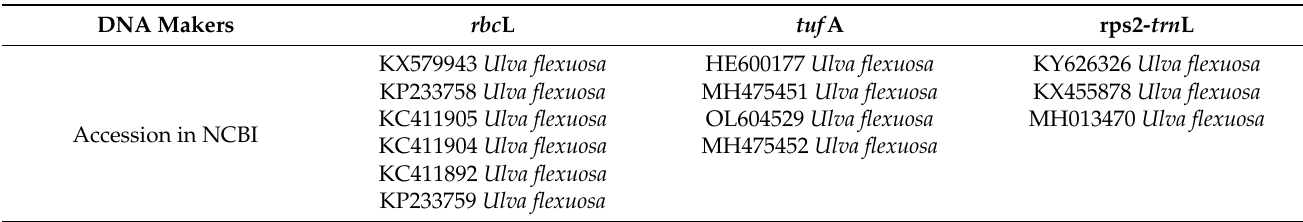
Table 4. Sequences of U. aragoensis mistakenly identified as U. flexuosa in the NCBI database. DNA